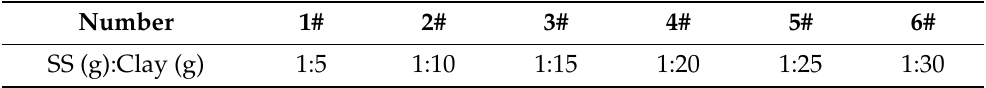
Table 4. Ratio and number of multiscale composite particles of sewage